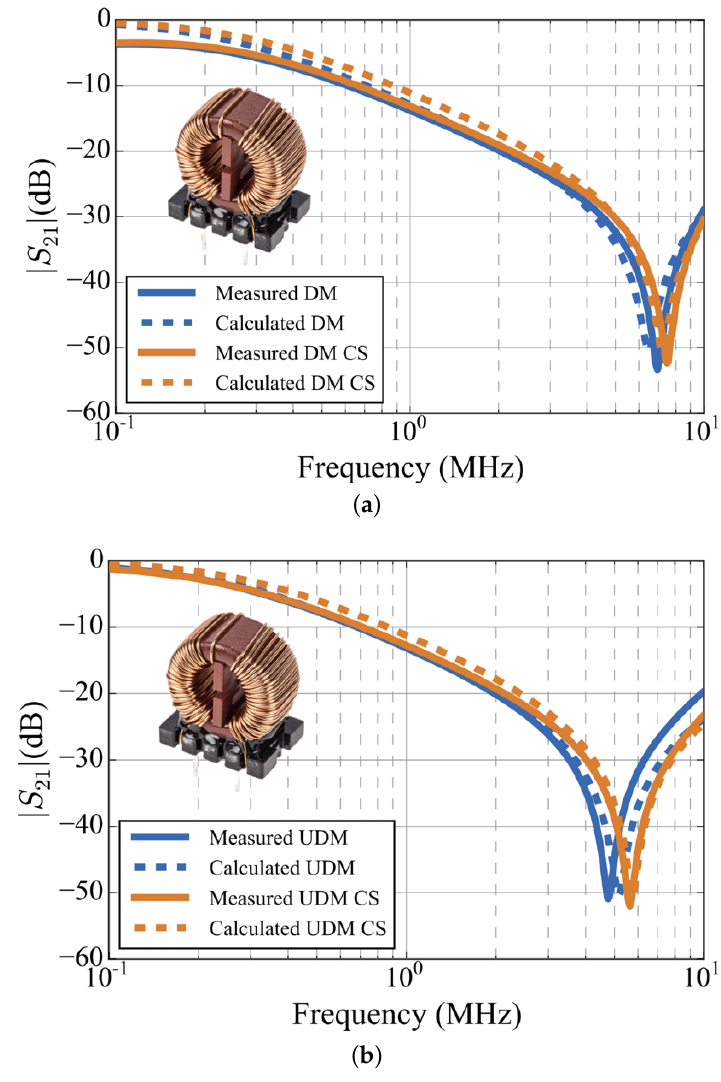
| ( a ) and | S UDM | ( b ) for the CMC listed as WÜRTH 21 21